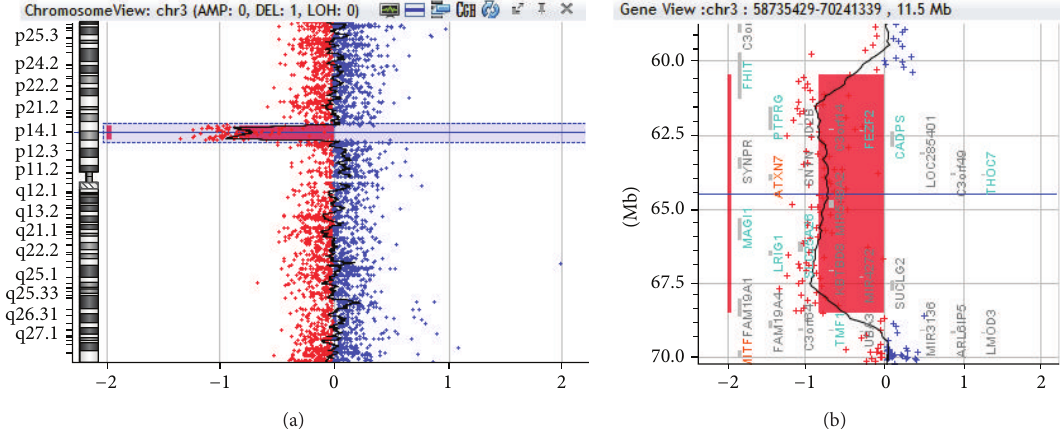
Figure 2: The array comparative genomic hybridization (CGH) profile of chromosome 3 showing an interstitial deletion. (a) View of chromosome 3 and (b) the enlarged view of the rearrangement as generated by CytoGenomics v.2.7 (Agilent Technologies). The deletion breakpoint was between 60.461.316 and 68.515.453 (3p14.2-p14.1). The size of the deletion was ∼ 8Mb.